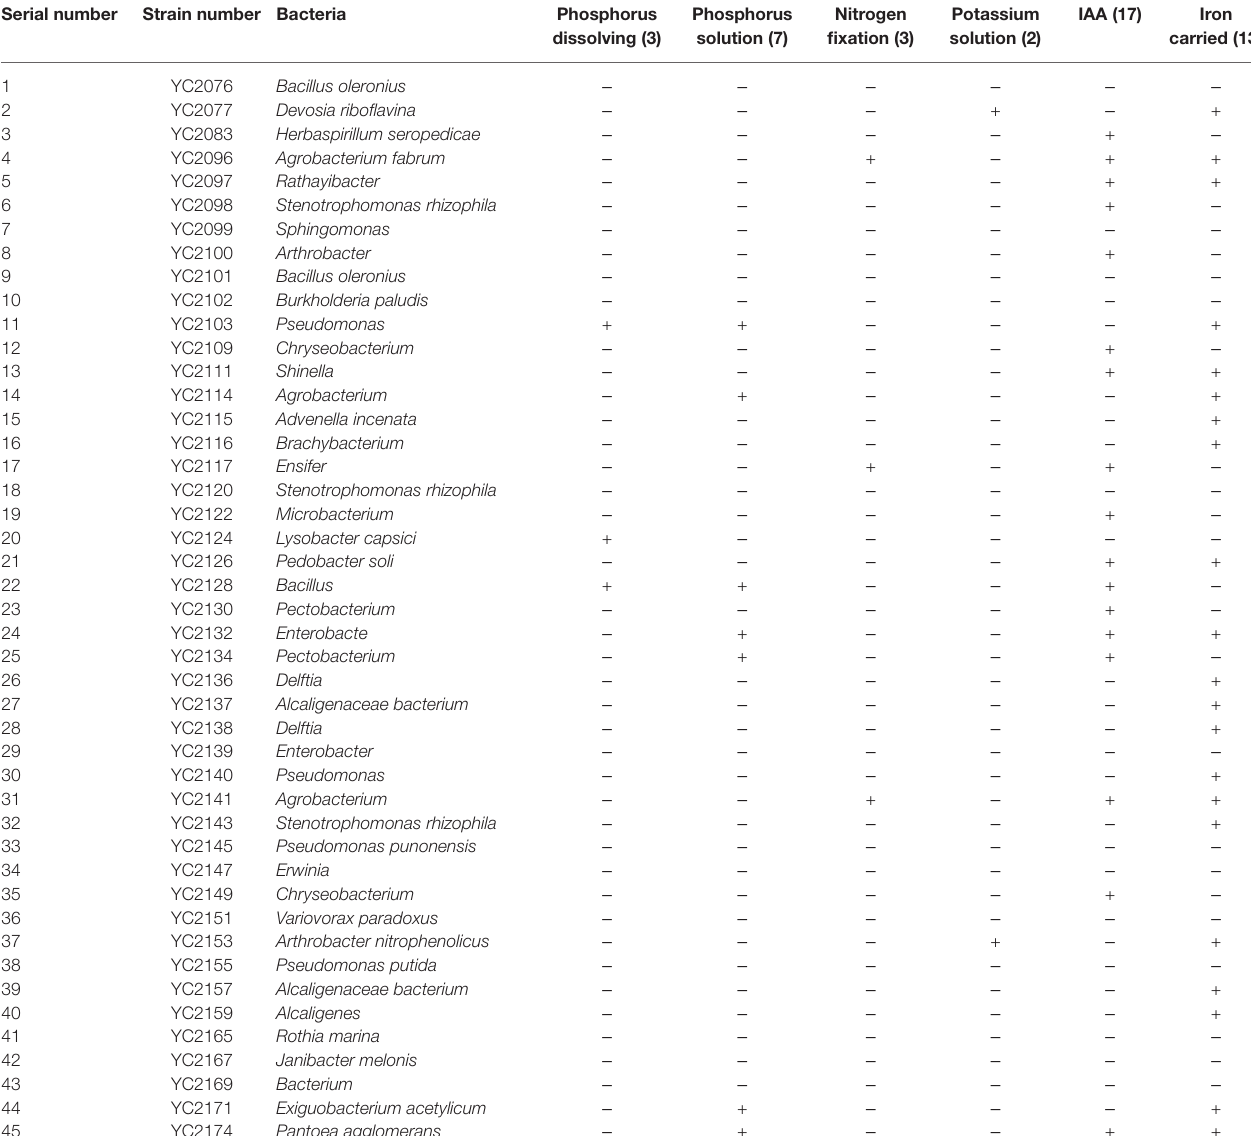
TABLE 1 | Test results of the growth-promoting activity of the strain. Serial number Strain number